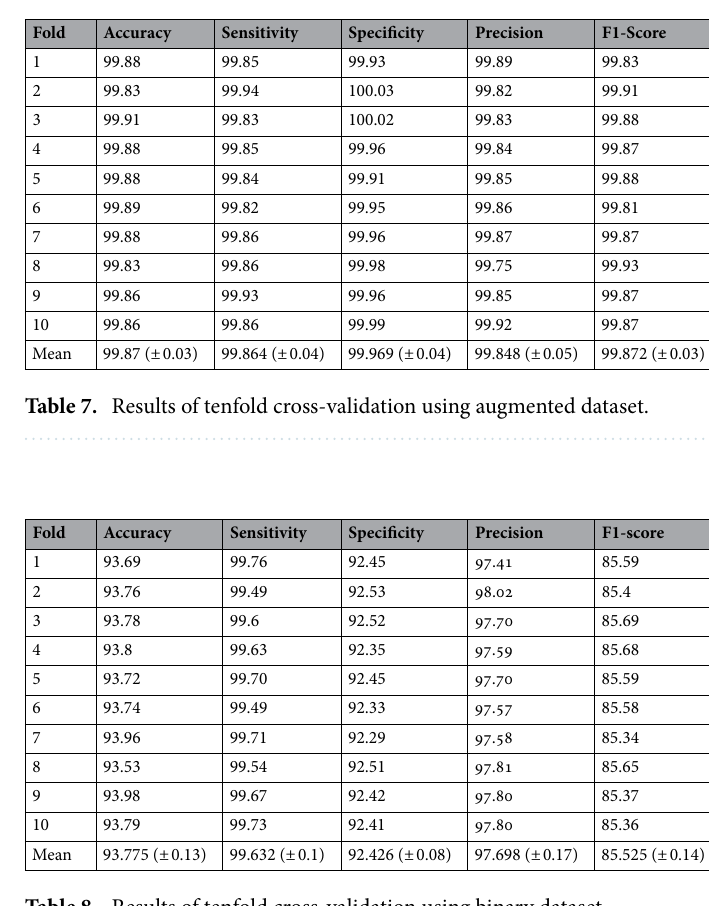
Table 8. Results of tenfold cross-validation using binary